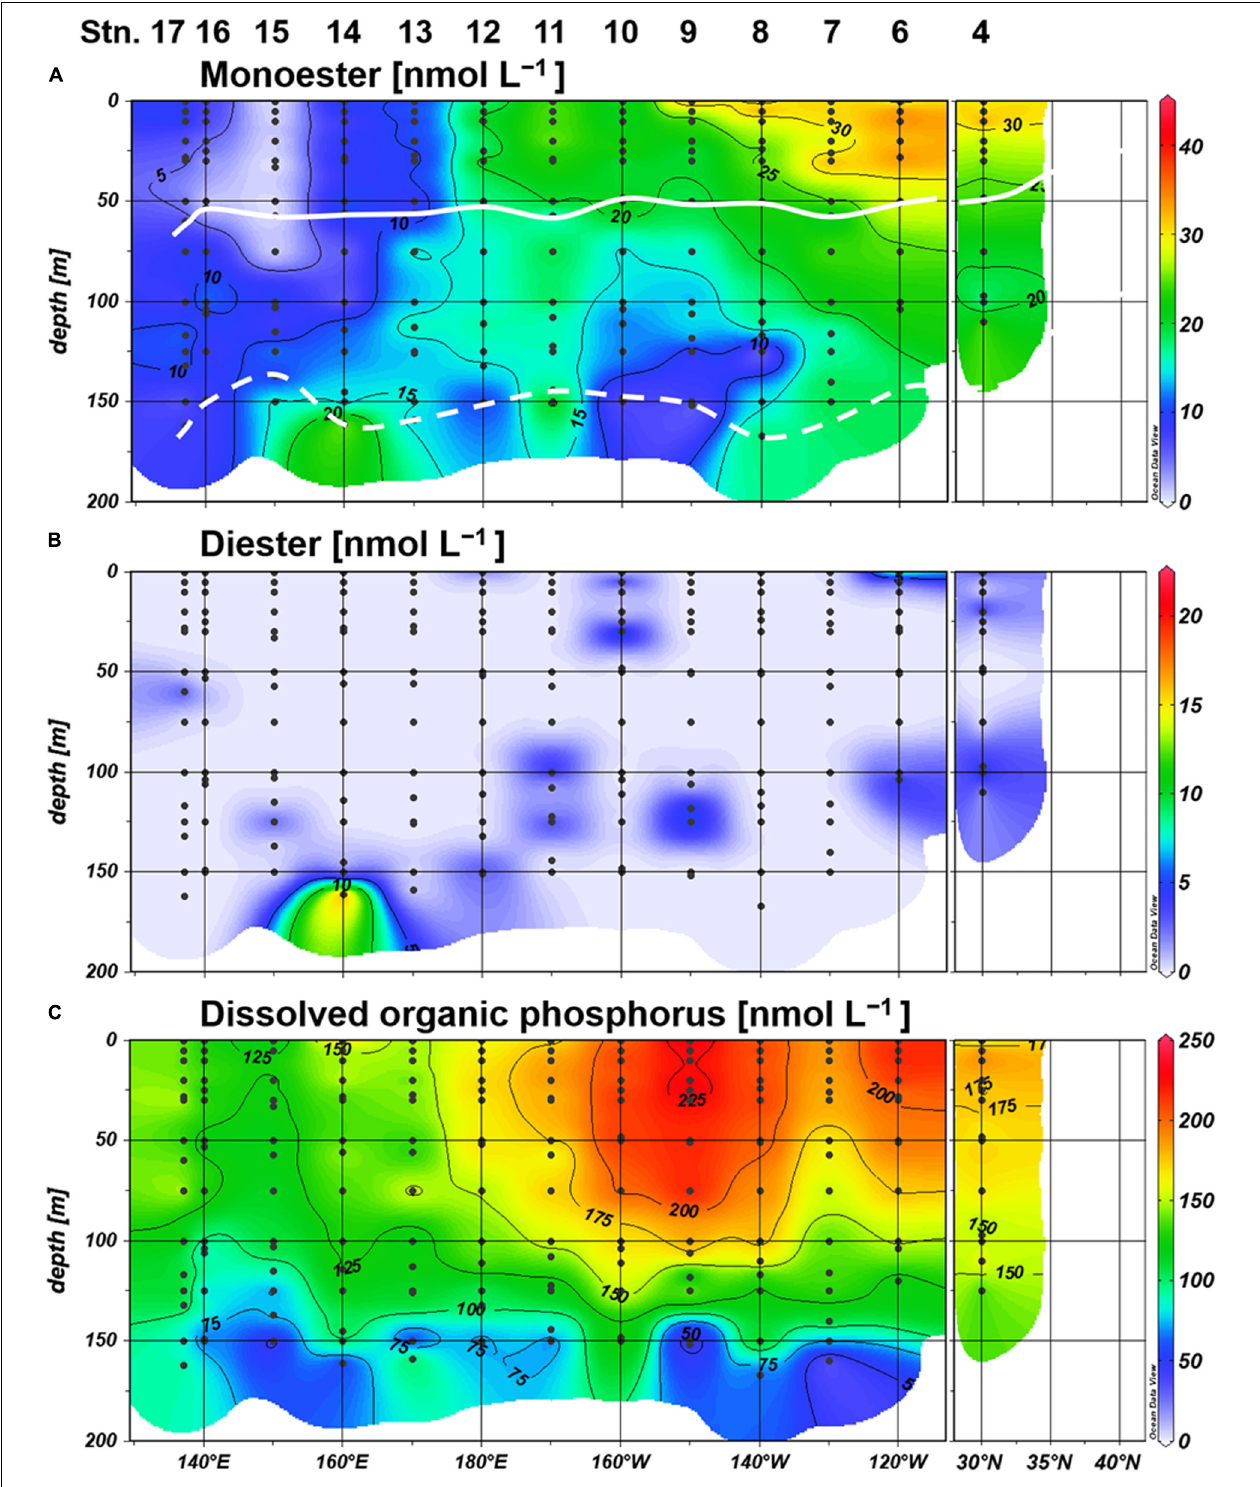
FIGURE 4 | Distributions of (A) monoester, (B) diester, and (C) dissolved organic phosphorus (DOP) concentrations. Light depths of 10% and 0.1% are indicated by white bold and dashed lines, respectively.